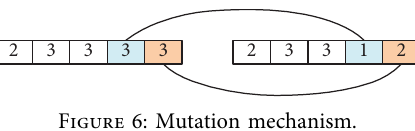
Figure 6: Mutation